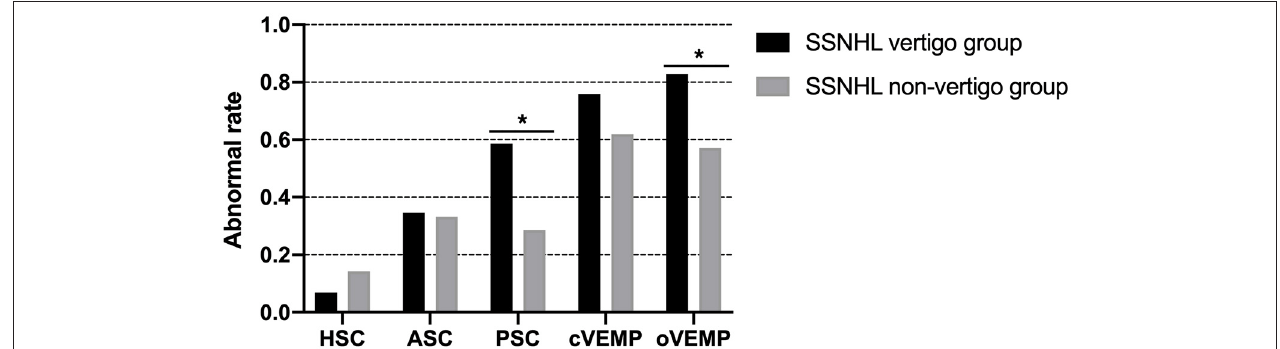
FIGURE 2 | The abnormal rates of vestibular tests of the SSNHL vertigo group and non-vertigo group. Significant differences in the abnormal rate of the PSC ( p = 0.035) and oVEMP ( p = 0.046) were found between groups. *Indicates significant ( p < 0.05) difference in vestibular function test between groups. SSNHL, sudden sensorineural hearing loss; HSC, horizontal semicircular canal; ASC, anterior semicircular canal; PSC, posterior semicircular canal; cVEMP, cervical vestibular-evoked myogenic potential; oVEMP, ocular vestibular-evoked myogenic potential.